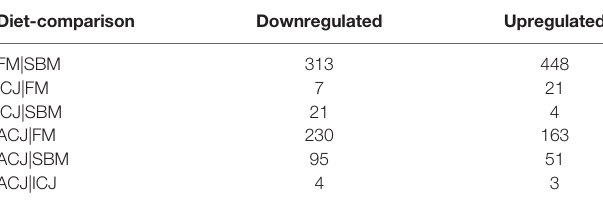
TABLE 3 | Signi fi cant differentially expressed genes (DEGs) per diet-comparison. Diet-comparison Downregulated Upregulated FM|SBM